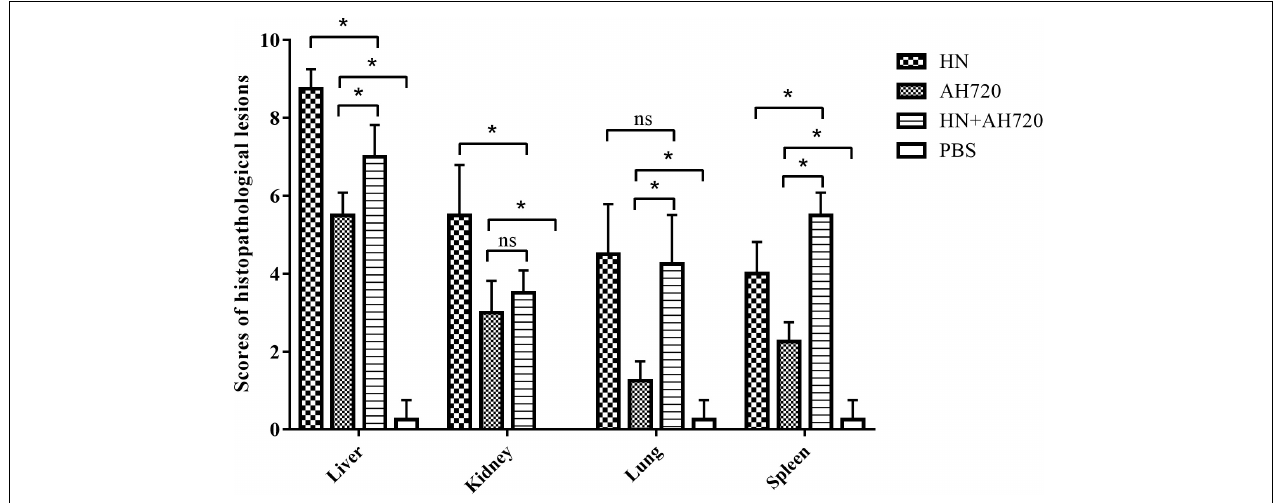
FIGURE 4 | Scores of histopathological lesions in sampled tissues of chickens in different infection groups. Lesion scoring: 0 for no lesions, 1-3 for mild lesions, 4-6 for moderate lesions, and 7-10 for severe lesions. The error bars indicate SEM. ns represents not significant, * P < 0.05 (Student’s t -test).